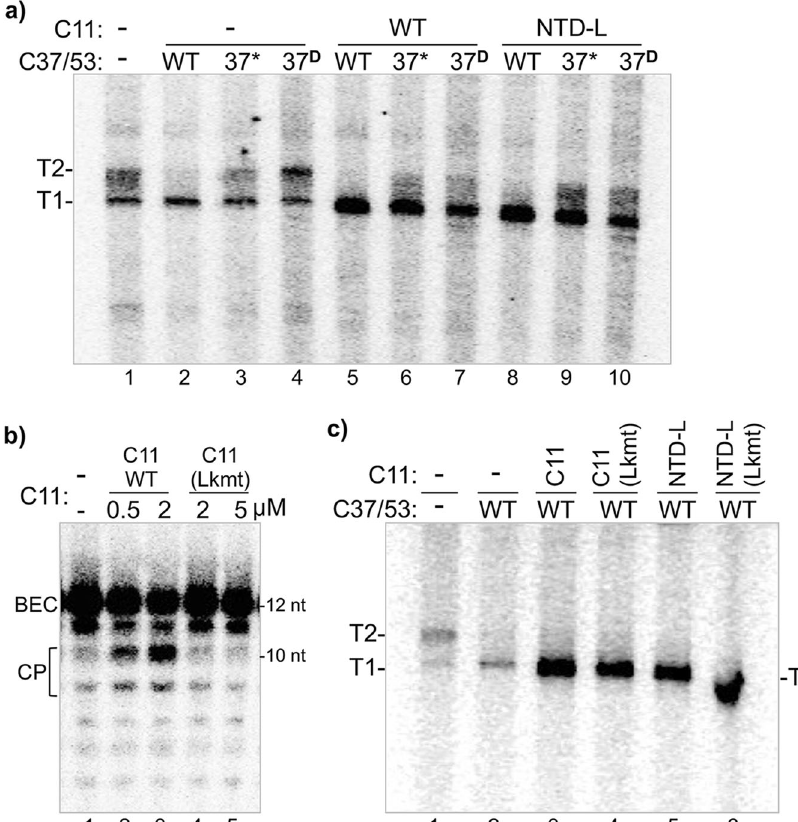
Fig. 7 C11 can activate C37 CTD-termination loop mutants for recycling. a The NTD-L of C11 can activate C37-termination/initiation loop mutants for Pol III recycling. In vitro transcription reactions using a batch of SUP4-tRNA Tyr complexes reconstituted with Pol III-core alone (lane 1), or Pol III-core preincubated with C37/53 or C37*/53 in which the fi ve amino acids at positions 226 – 230 are substituted with alanine, or C37 D /53 in which they are deleted, alone (lanes 2 – 4), with C11 (WT, lanes 5 – 7) or with the NTD-L (lanes 8 – 10), as indicated. The T1 and T2 bands are as described for Fig. 4b and d. b , c Invariant linker mutations affect RNA 3 ′ -cleavage activity but not Pol III recycling. The two C11 constructs with D52A,D53A mutations to the invariant central linker (Lkmt) are shown in Fig. 2a. b The RNA 3 ′ -overhang substrate representing Pol III backtrack arrested ECs was incubated with either buffer alone, C11 or C11-(Lkmt) in amounts indicated above the lanes under standard assay conditions. Cleavage products (CP) are indicated. c Results of in